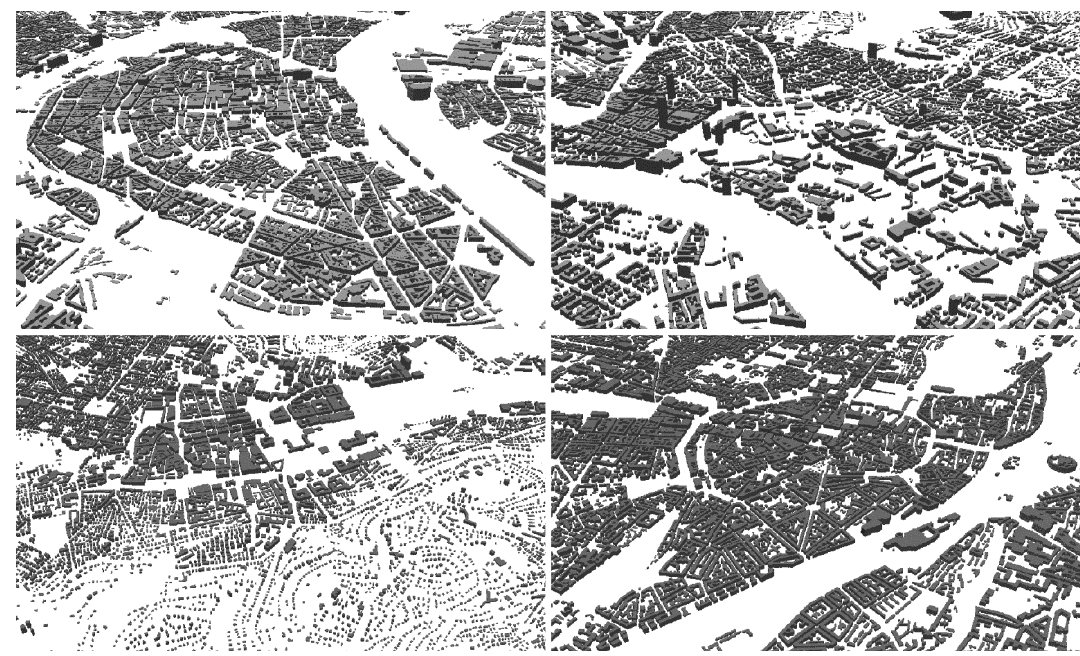
Figure 3. Perspective view of 3D building models derived from space-borne Cartosat-1 height measurements and building footprints from digital topographic maps (top left: Cologne; top right: Frankfurt; bottom left: Stuttgart; bottom right: Munich). Topographic map: © GeoBasis-DE/BKG (2010), cf. [55].